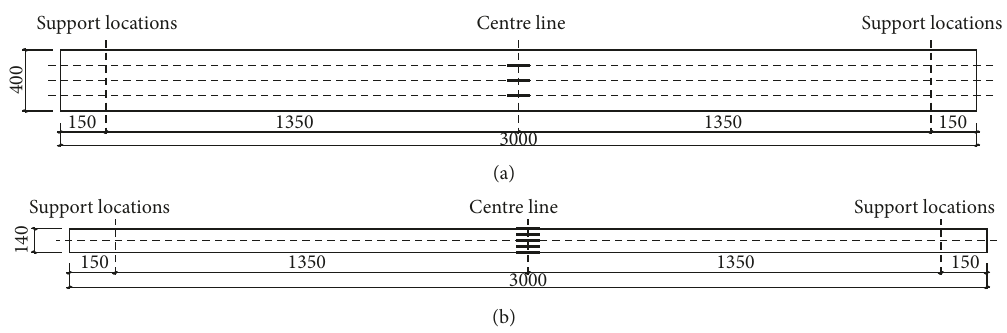
Figure 13: Strain arrangement of the stone slab: (a) slab bottom (top) (mm) and (b) slab side (mm).